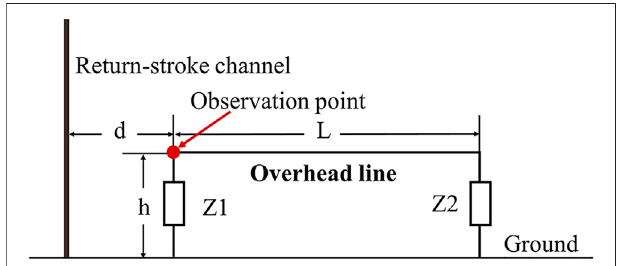
FIGURE7| Thesketch map ofthe locationsofthe lightningchannel and the overhead